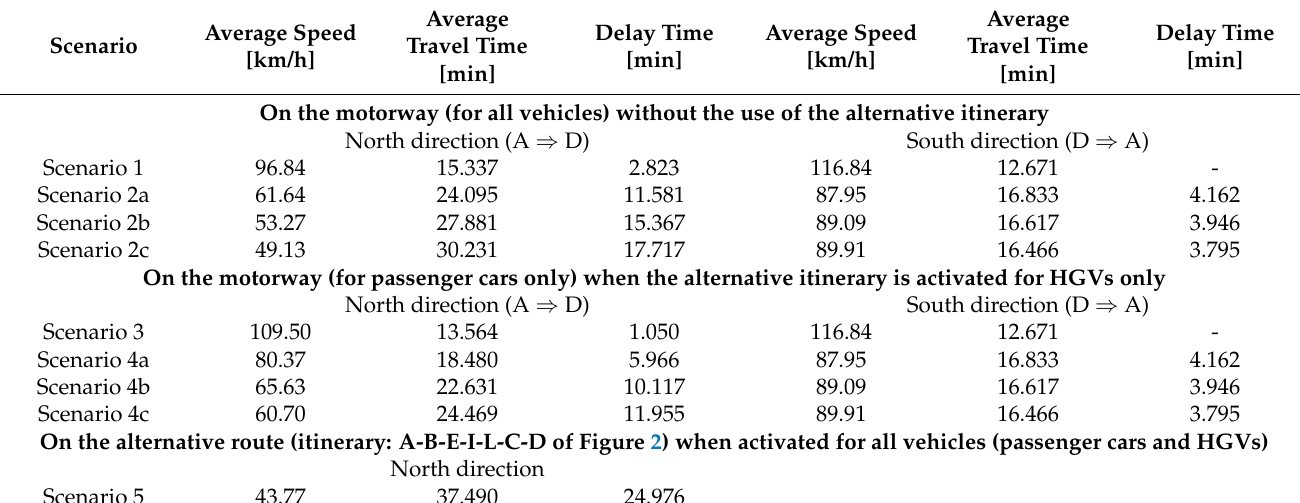
Table 5. Simulation results: average speed, average travel time, and delay time for the scenarios investigated when the north tube is partially or completely closed for 2 h (for example: Scenario 2c, delay time on the motorway for all vehicles = 30.231 − 12.514 = 17.717 min; Scenario 4c, delay time on the motorway for passenger cars only = 24.469 − 12.514 = 11.955 min; Scenario 5, delay time on the alternative itinerary for all vehicles = 37.490 − 12.514 = 24.976